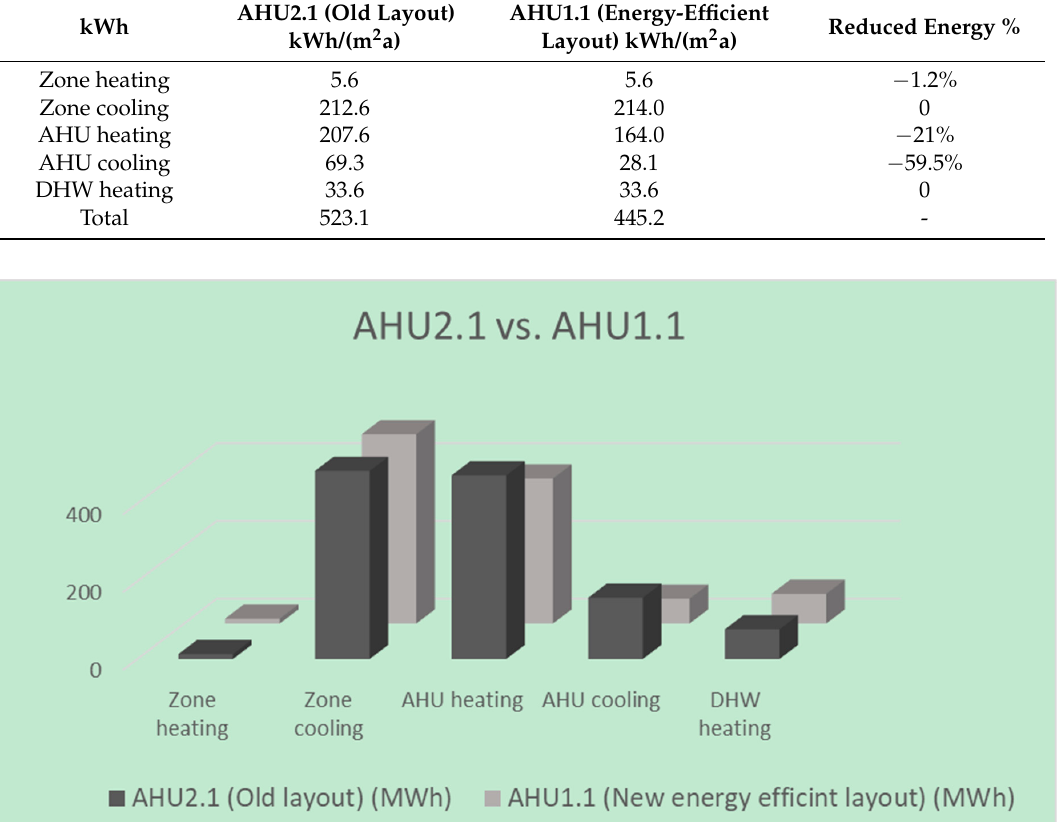
Table 3. The yearly energy consumption results of the simulation for AHU1.1 and AHU2.1.